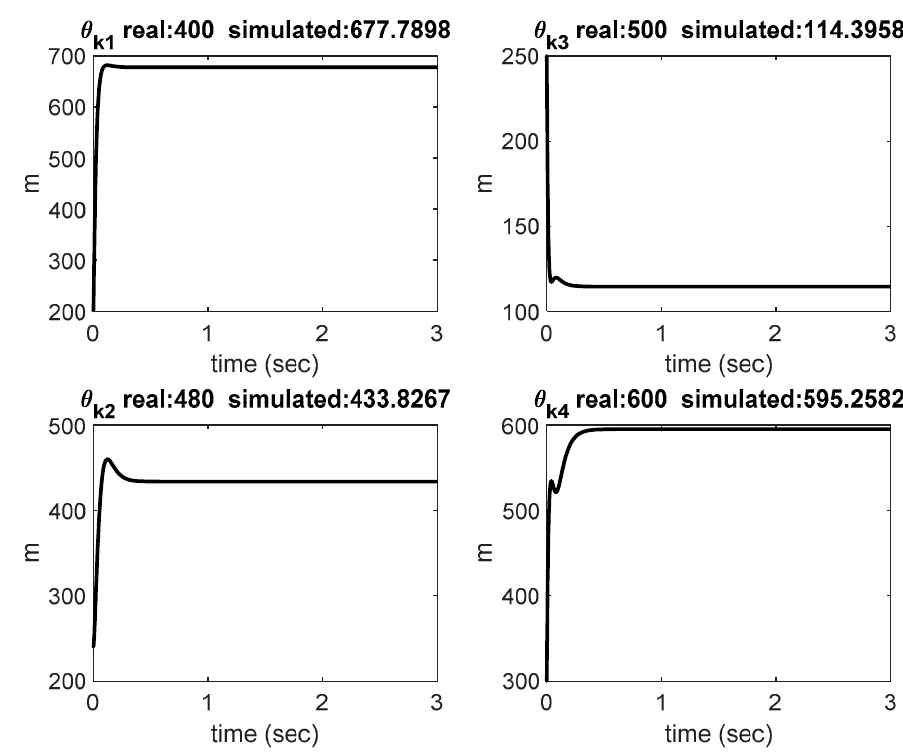
Figure 14. Estimation of kinematic parameters.